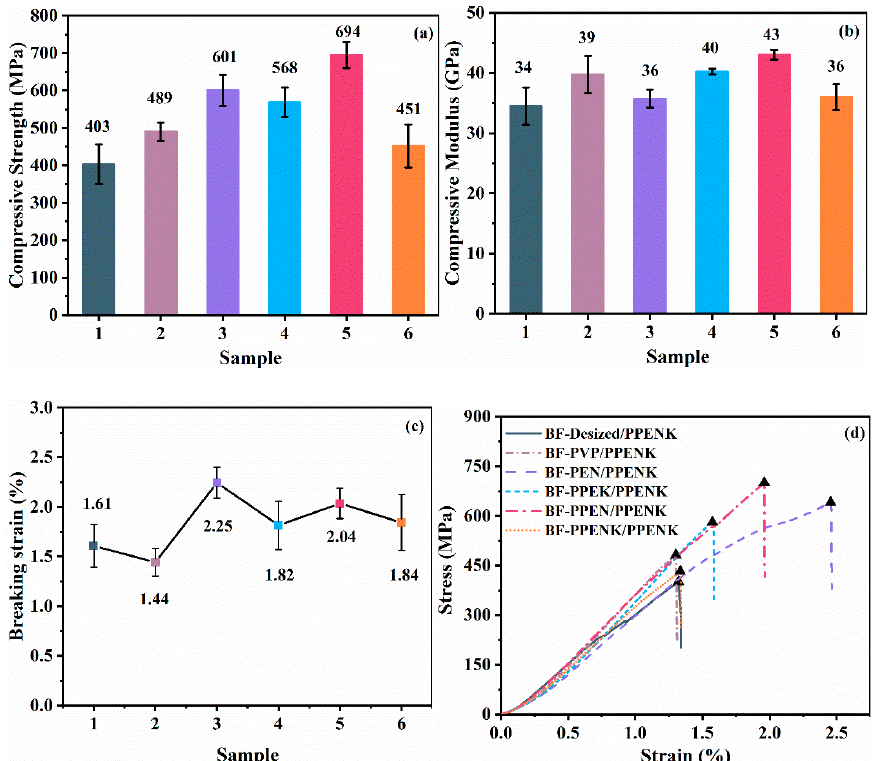
Figure 5. Compressive properties of the 1: BF—Desized/PPENK, 2: BF-PVP/PPENK, 3: BF- PEN/PPENK, 4: BF-PPEK/PPENK, 5: BF-PPEN/PPENK and 6: BF-PPENK/PPENK composites; ( a ) strength, ( b ) modulus, ( c ) breaking strain and ( d ) stress–strain curves.